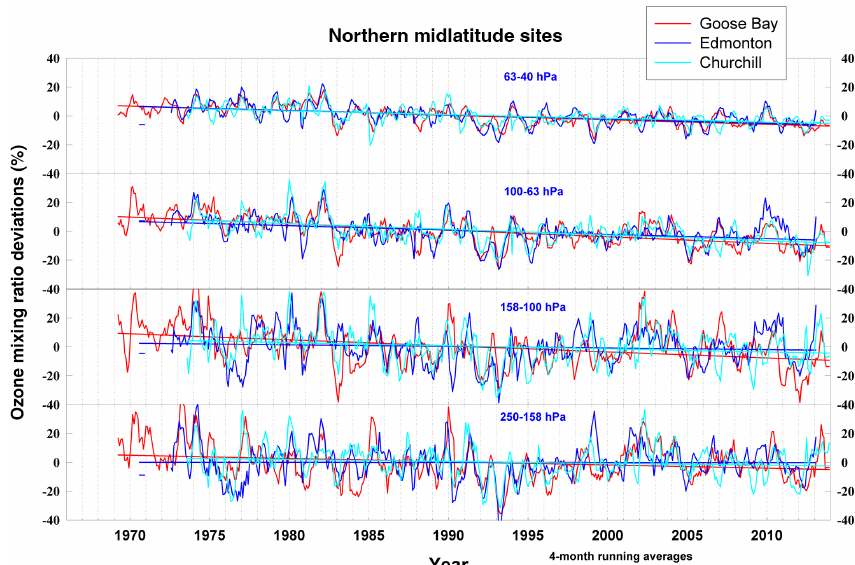
Figure 11. Percent deviations in average ozone mixing ratio for four lower stratospheric layers, using data from three midlatitude stations. Monthly anomalies have been smoothed with a 4-month running average. The overall station trend lines are shown. The troposphere and stratosphere have been explicitly separated; that is, integration of the 250–158hPa layer starts either at 250hPa or at the tropopause, when the latter is found above 250hPa.